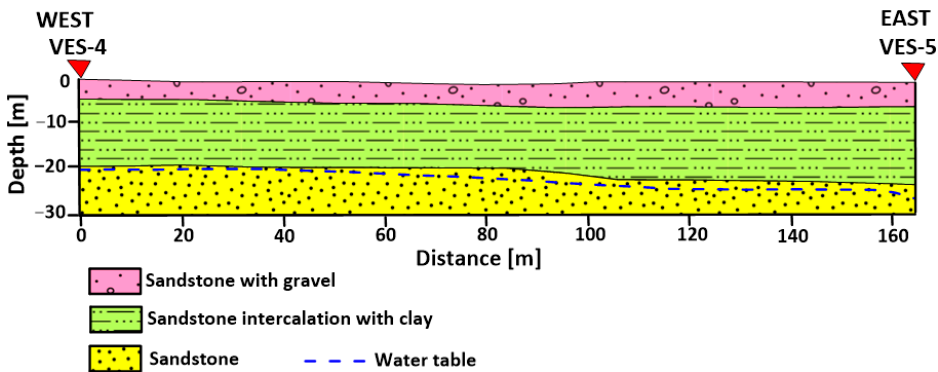
Figure 6. The southern geoelectric cross-section in the study area.